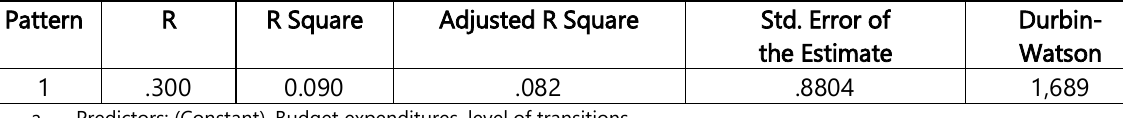
Table 10: Model Summary (Source: Authors’ calculation) Pattern R R Square Adjusted R Square Std. Error of 1 .300 0.090 .082 .8804 1,689